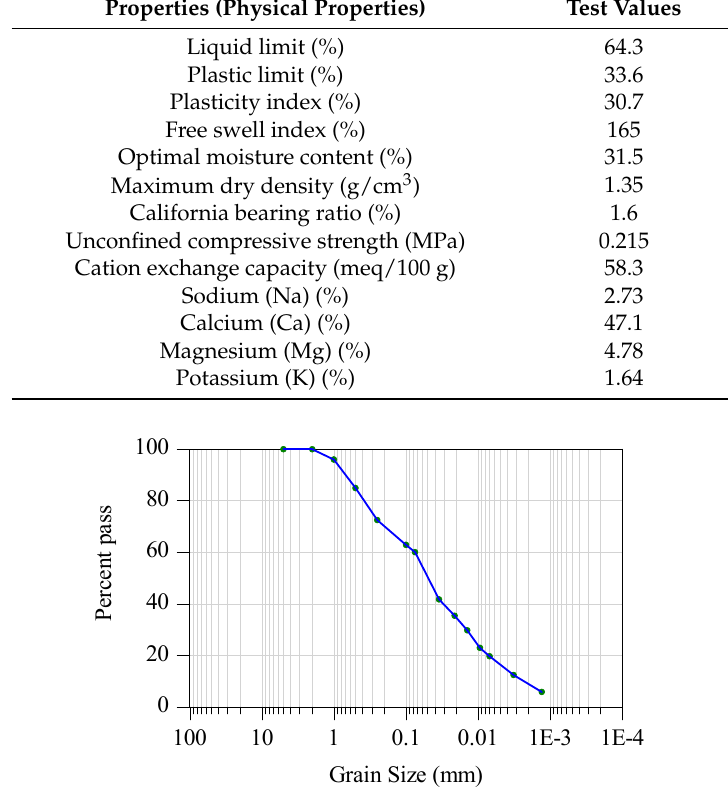
Figure 1. Grain size distribution of the black cotton soil (BCS) samples.